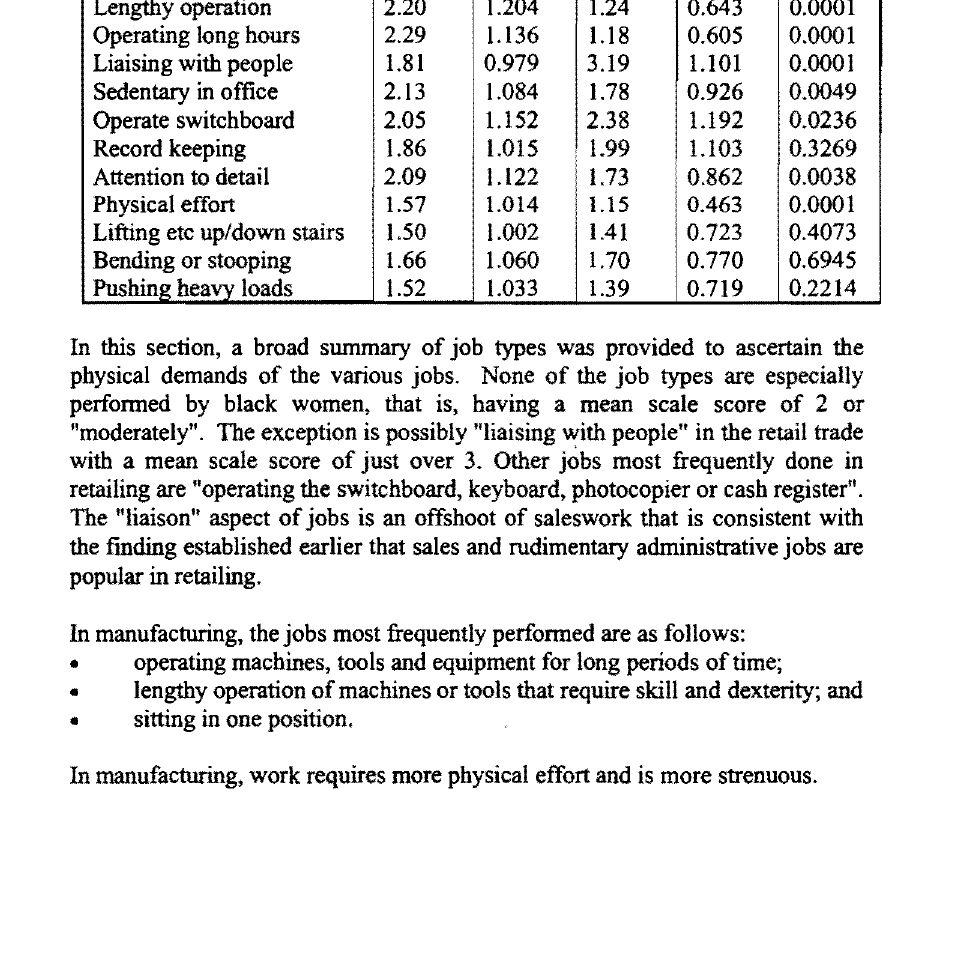
Type of jobs black women perform in manufacturing and